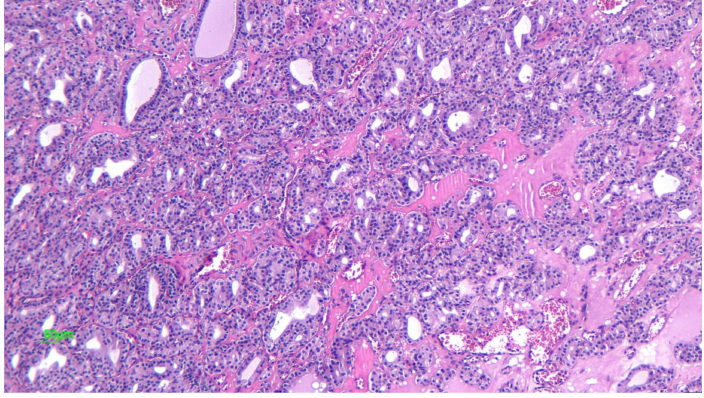
Figure 16. Macro- and microfollicles containing little or no colloid (10 × HE) (courtesy of Dr R. Chirculescu). Papillary carcinoma is the most common malignancy in struma ovarii and has the same histologic appearance as its thyroid counterpart (Figure 17).